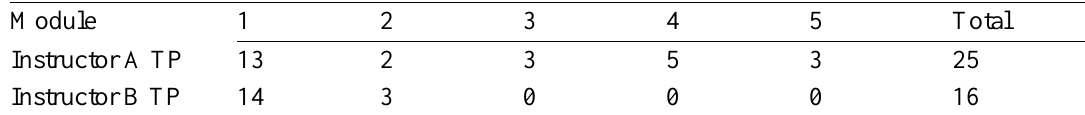
Individual Instructor TP Indicators in Threaded Discussion per Module by Course